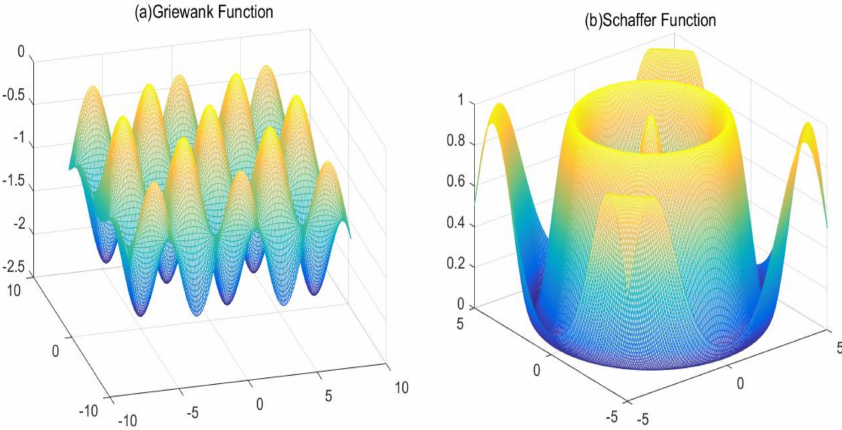
Figure 5. Distribution chart of test functions.